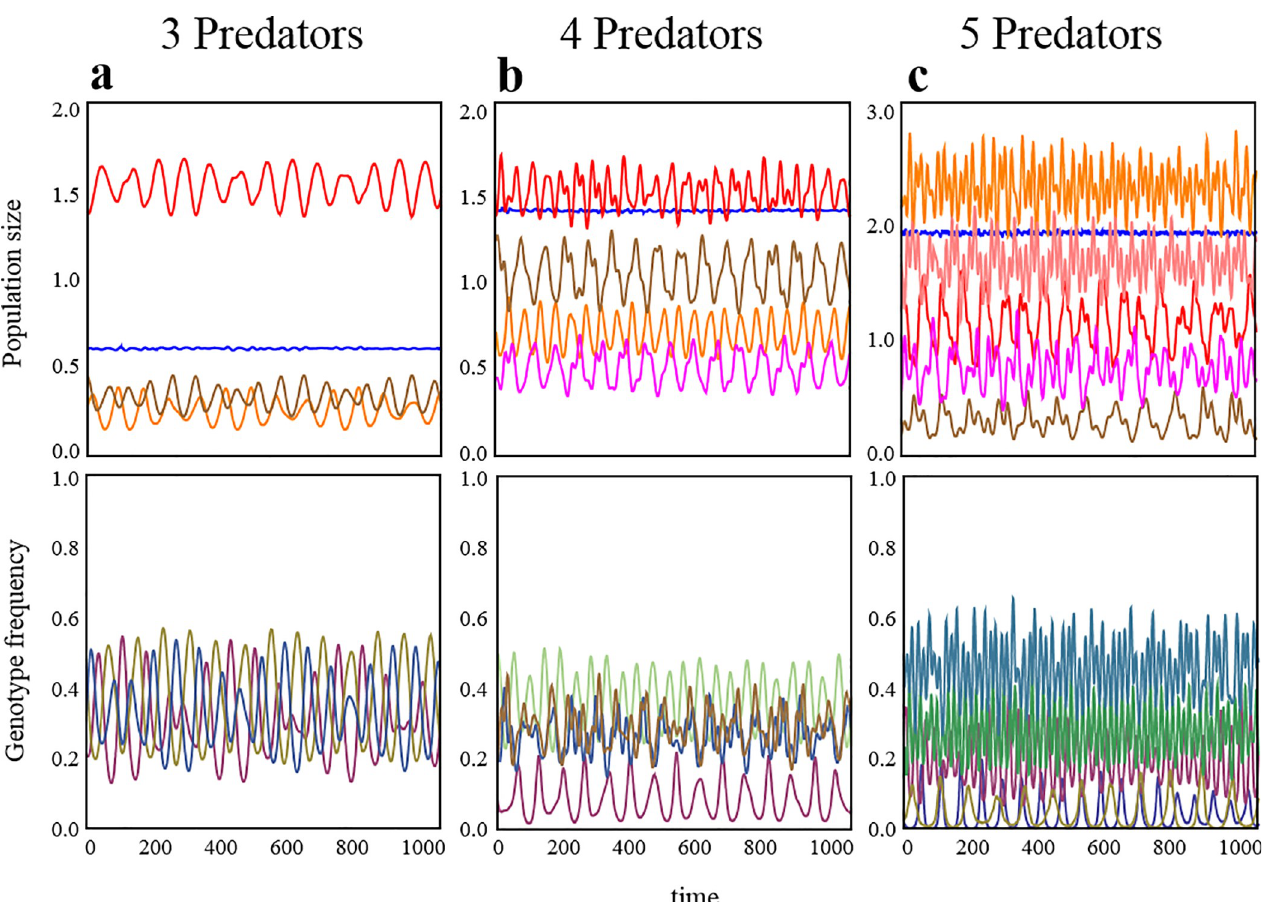
Fig 3. Examples of eco-evolutionary dynamics in predator systems with more than two predators: (a) Three predators coexist, (b) Four predators coexist, (c) Five predators coexist. In (a–c), initial genotype numbers are 6, 8, and 10, respectively. Parameters used in each case are shown in S1 Text.